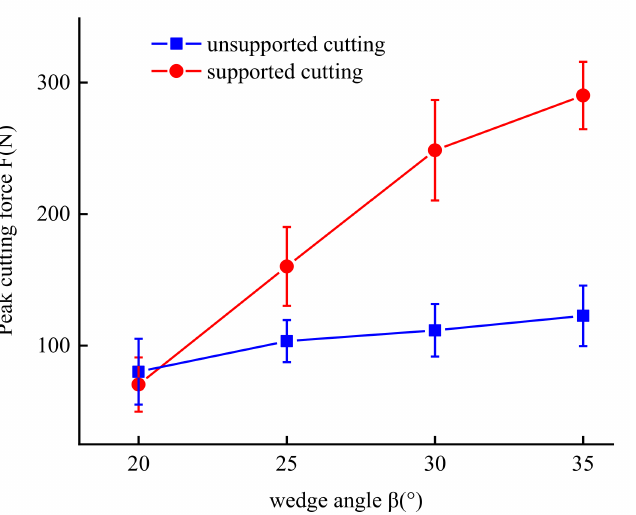
Figure 9. Relationship between tool wedge angle and peak cutting force. Note: branch diameter is 9–10 mm, average cutting speed is 3.36 m · s − 1 , slip cutting angle is 20 ◦ , cutting gap is 1 mm, cutting height is 5 cm, moisture content is 24.8%–27.3%.